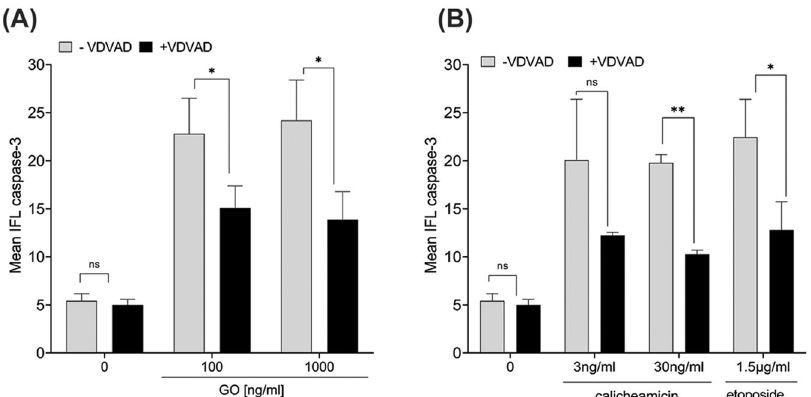
Fig. 2 Reduced GO-, calicheamicin-, and etoposide-induced caspase-3 activation in AML cells upon caspase-2 blockage. A , B HL60 cells were exposed to GO-, calicheamicin- or etoposide for 48 h with or without pre-treatment with the caspase-2 inhibitor z-VDVAD-fmk (10 µM) for 2 h. The amount of active caspase-3 in HL60 cells was quanti fi ed by fl ow cytometry. Caspase-3 associated mean fl uorescence intensity is presented. Histograms from one representative experiment showing activation of caspase-3 by a shift to the right is presented in Supplementary Fig. S1.